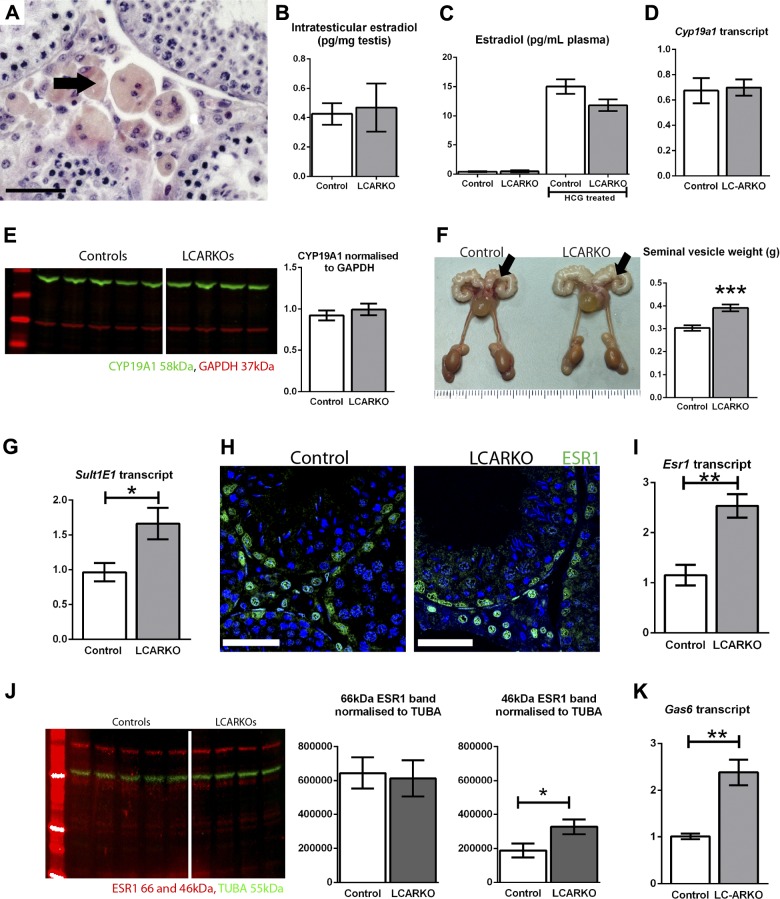
LCARKO testes show an increase in ESR1 signaling. A) Multinucleate cells that stain pink/orange with hematoxylin and eosin are noted in ≥6-mo-old LCARKO testis interstitium (arrow). Scale bar, 50 µm. B) Intratesticular estradiol levels are not significantly different between control and LCARKO mice at d 80. C) Plasma estradiol levels are not significantly different between control and LCARKO mice at d 80 or for hCG treated at d 100. D) Cyp19a1 is not significantly different in LCARKO testis compared to controls at d 80. E) Levels of CYP19A1 (green; 58 kDa) normalized to GAPDH (red; 37 kDa) are not significantly different between LCARKO and controls at d 100. Error bars, SEM. F) Seminal vesicles are visibly larger (arrows) and also significantly heavier (***P < 0.001) in LCARKO compared to control mice post 6 mo of age. G) Sult1e1 gene expression is significantly increased (*P < 0.05) in LCARKO testis compared to controls at d 80. H) ESR1 (green) is localized to Sertoli, PTM, and Leydig cell nuclei in both control and LCARKO testis. Scale bars, 50 µm. I) Esr1 gene expression is significantly increased (**P < 0.01) in LCARKO testis compared to controls at d 80. J) Levels of the 46 kDa isoform of ESR1 (red) normalized to α-tubulin (red; 55 kDa) are significantly increased in LCARKO testes compared to controls at d 100 (P < 0.05), but the levels of the 66 kDa isoform are not significantly different. K) Gas6 gene expression is significantly increased (**P < 0.01) in LCARKO testis compared to controls at d 80.